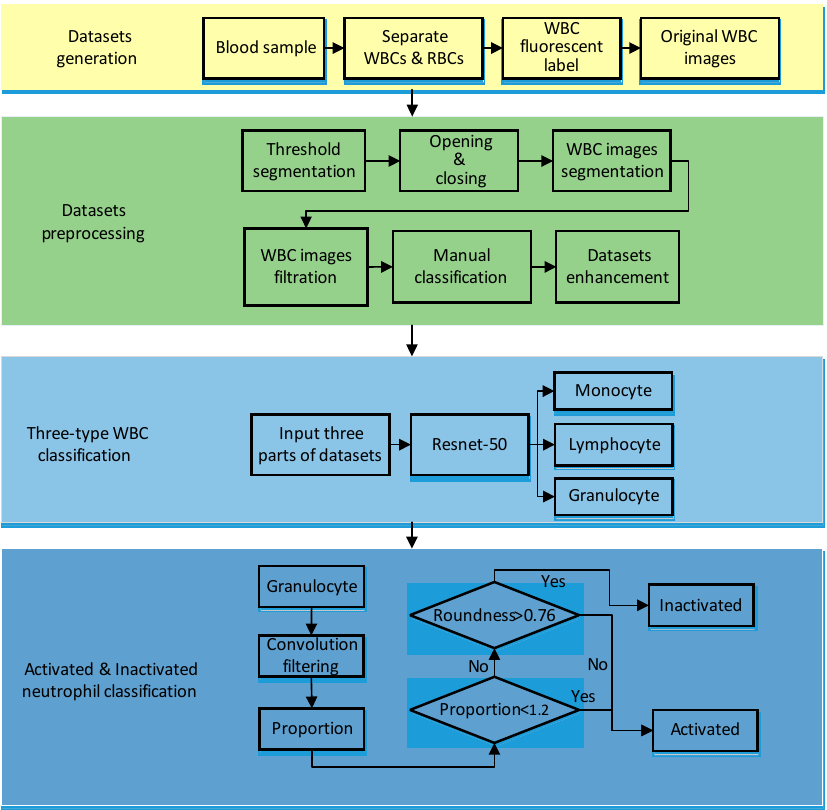
Figure 2. Whole processing flowchart for WBC classification.